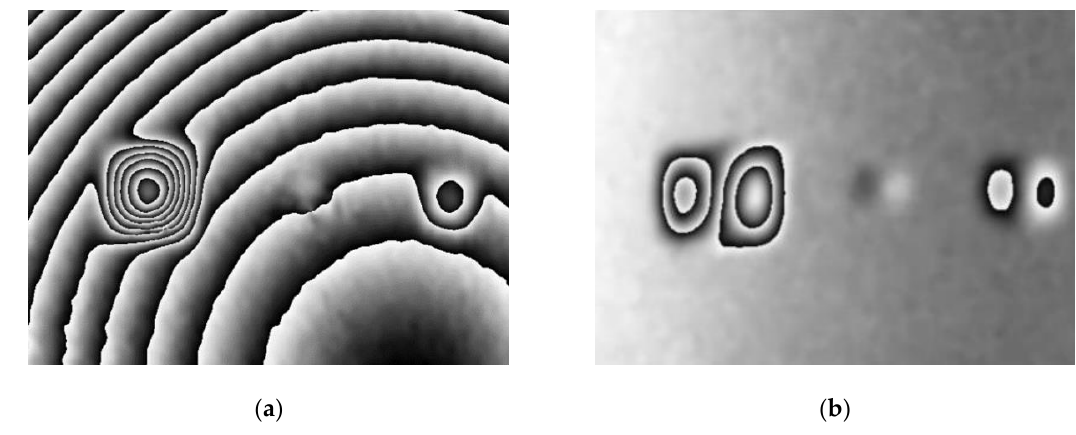
Figure 3. ( a ) Holographic NDT result, ( b ) shearographic NDT result.